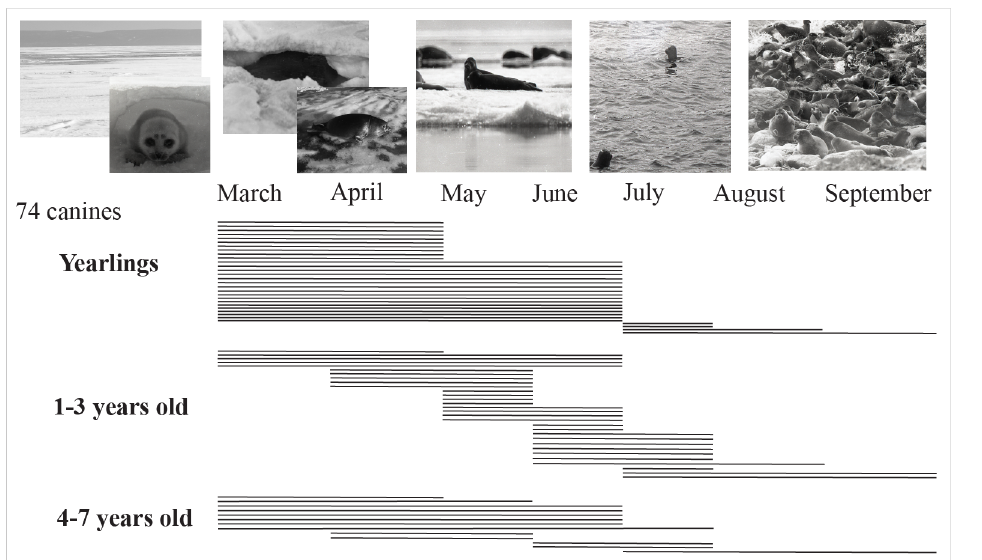
Fig 6. Seal seasonality data at Sagan-Zaba II by age groups (photographs by V.D. Pastukhov). Each bar represents a season of death estimation for a single individual.